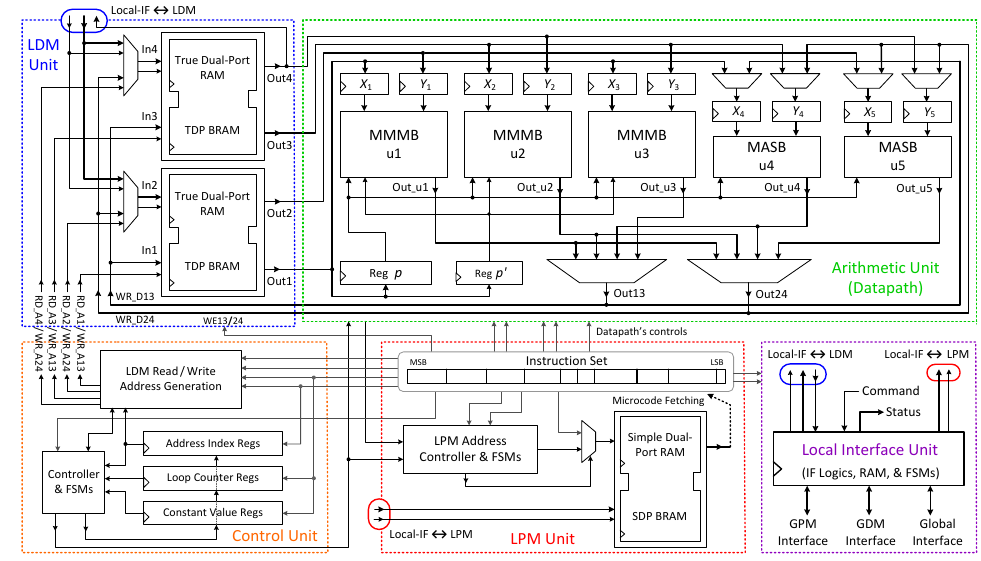
Figure 2: Architecture details of the CP